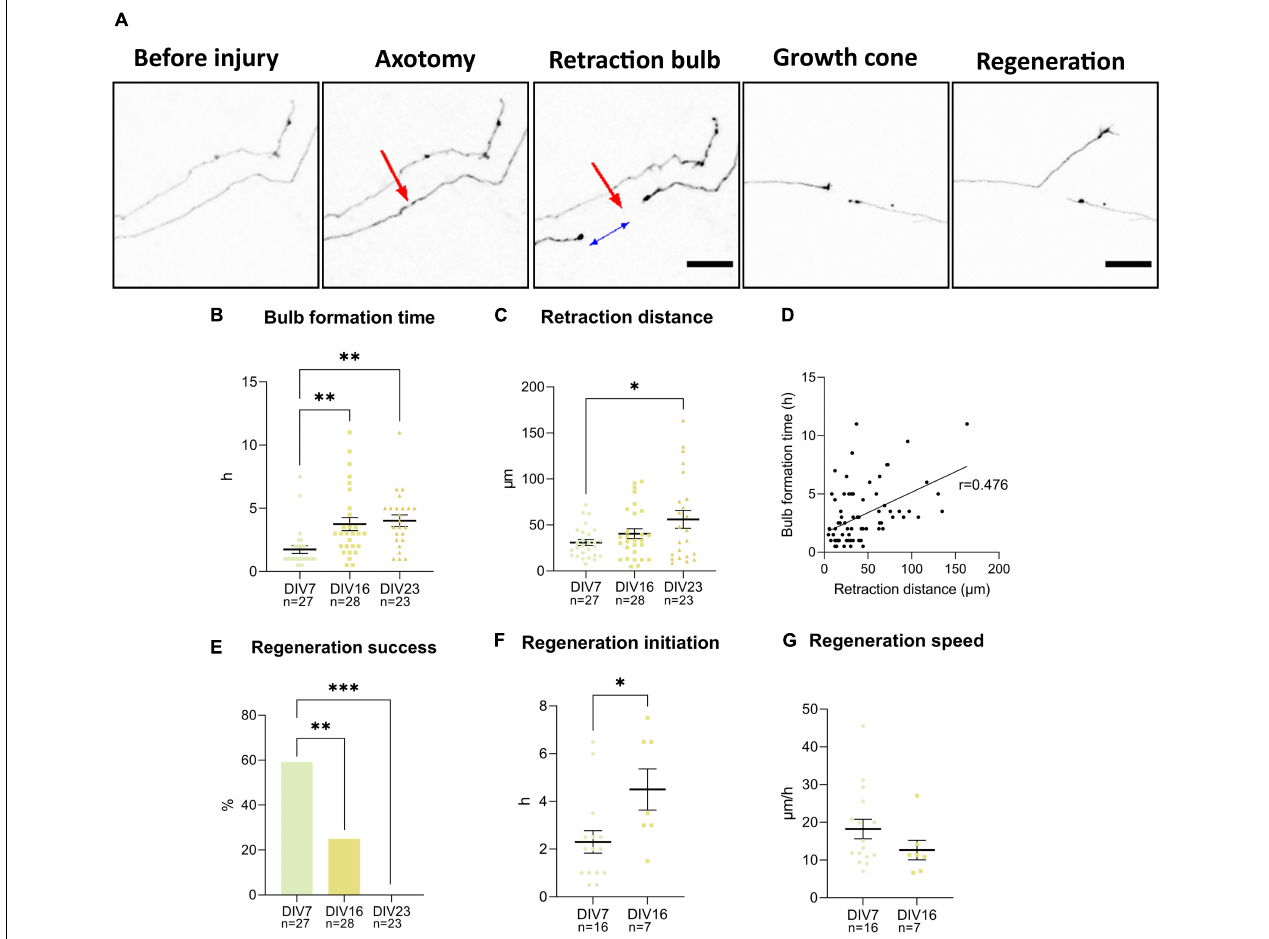
FIGURE 9 | Axotomy of the GFP (black) transfected neurons was achieved using a 900 nm laser (A) . Red arrow points at the location of the cut. Retraction bulb formed at certain distance from the injury site as indicated by the blue arrow. Bulb formation time (B) and retraction distance (C) were lower in DIV7 neurons. These two parameters have a positive linear relationship demonstrated by Pearson’s correlation coefficient (D) . Percentage of regenerating axons decreased significantly between DIV7 and DIV16 (E) . Time between retraction bulb formation and growth cone formation increased significantly at DIV16 (F) , while speed of regeneration decreased marginally (G) . Scale bars: 25 µ m. Data are presented as means ± SEM of n number of cells from 3 biological replicates; ∗ p < 0.05, ∗∗ p < 0.01, ∗∗∗ p <